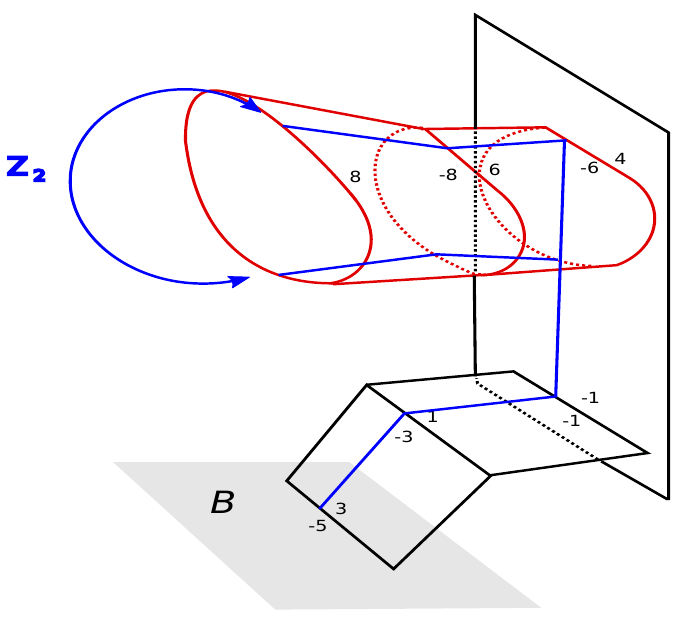
Figure 10. Geometry of the 5